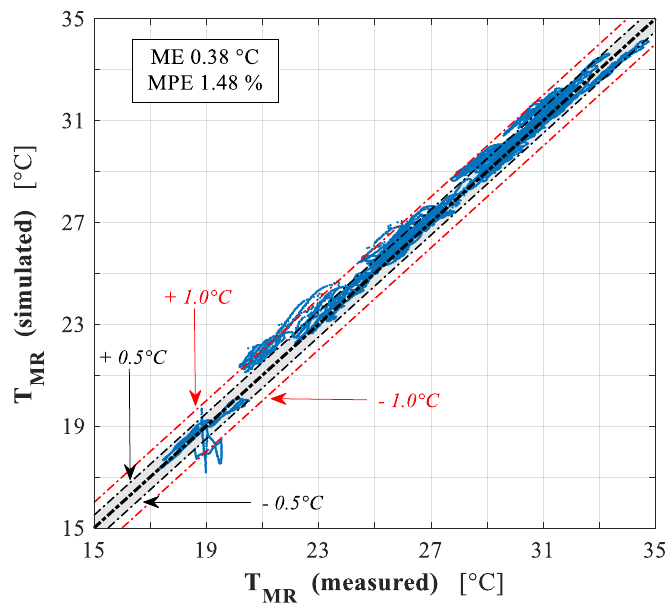
Figure 26. Mean radiant temperature: simulated vs. experimental results (from February to